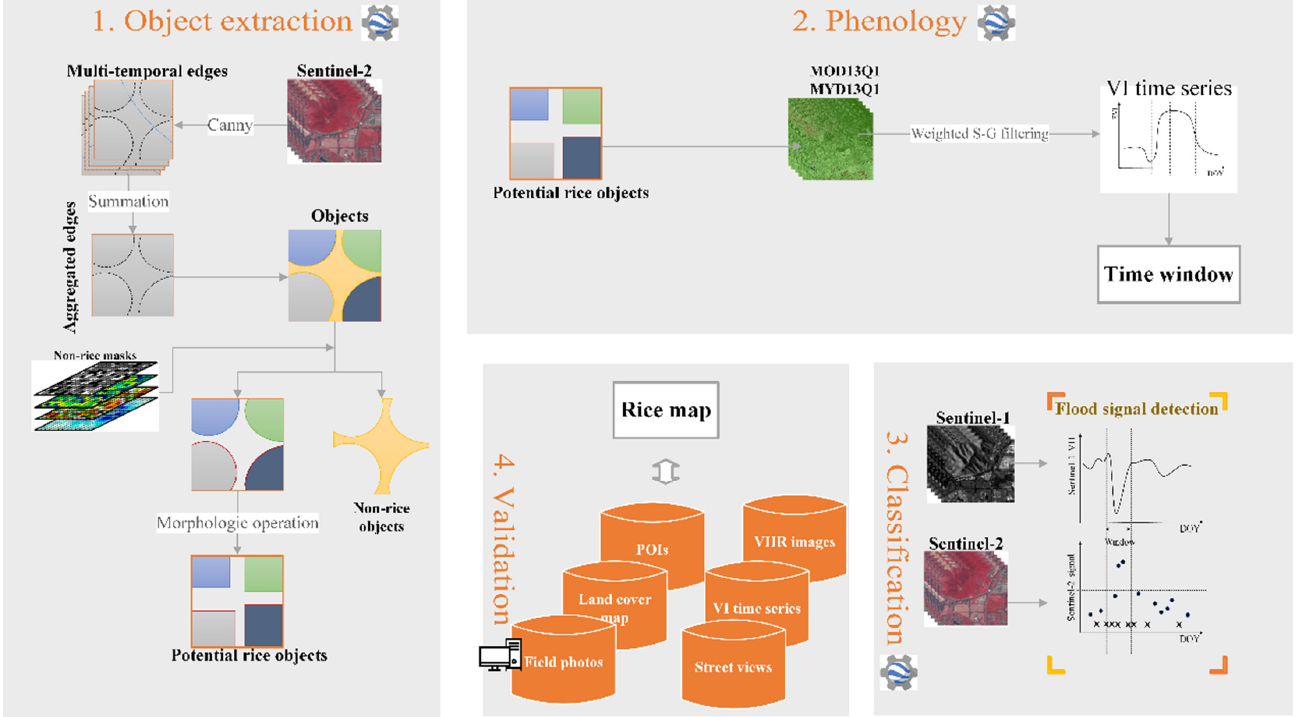
Figure 2. Schematic diagram of the processing chain for the proposed algorithm. The first three modules are implemented in GEE while the fourth module, validation, is implemented on a local